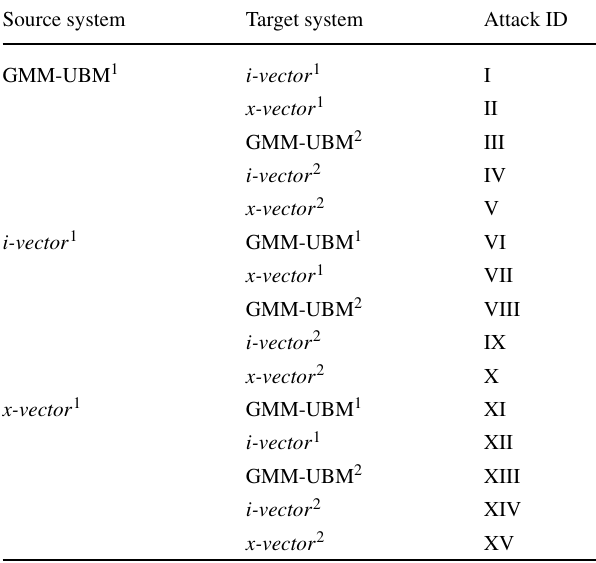
Table 3 Experimental configuration for evaluating transferability Source